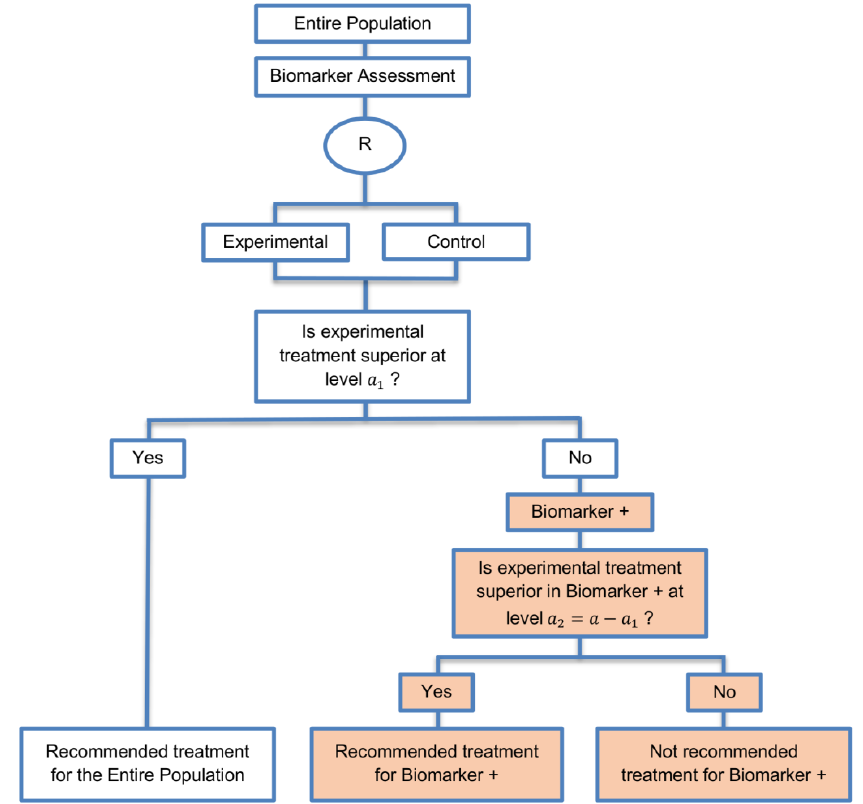
Figure 9. Biomarker-positive and overall strategies with fall-back analysis. “R” refers to randomization of patients. Uncolored boxes are referred to the first stage of the trial and colored boxes are referred to the second stage of the trial.